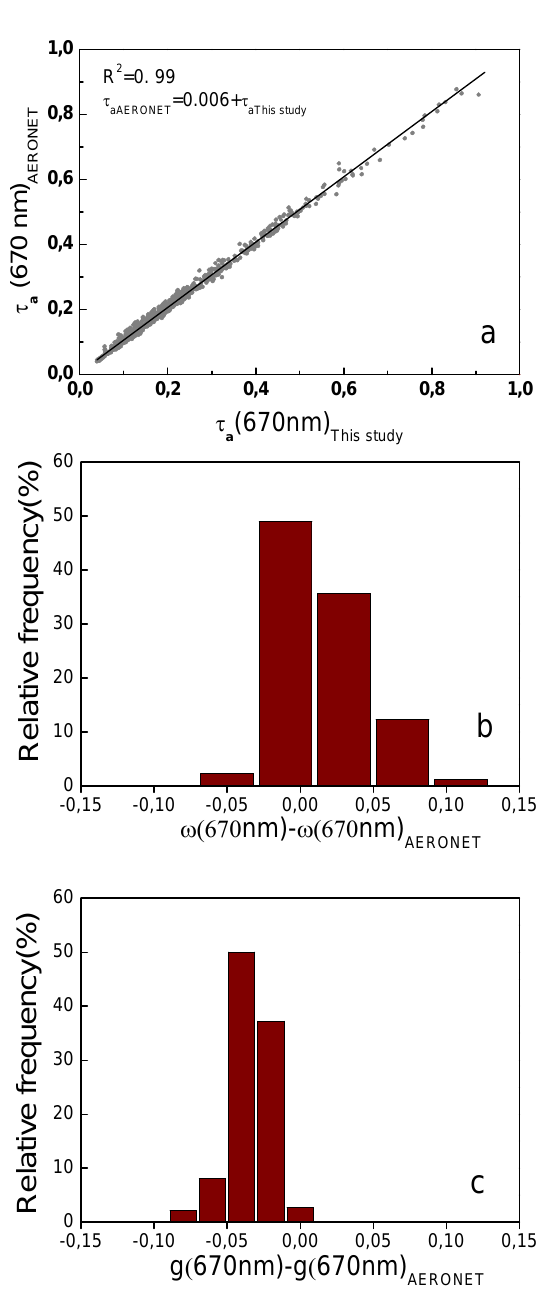
Fig. 2. (a) τ a (670nm) provided by AERONET vs the data com- puted by our methodology. (b) and (c) Frequency distributions of the absolute differences between ω (670nm) and g (670nm) pro- vided by AERONET and computed by the Principal plane inversion algorithm.